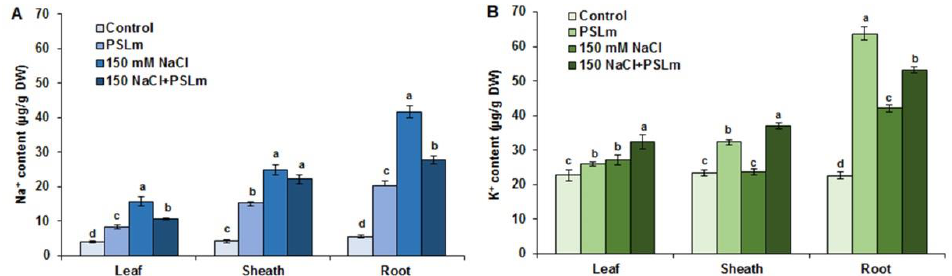
Figure 4. Na + content ( A ) and K + content ( B ) in leaves, sheaths, and roots under normal and salt- stressed (150 mM NaCl) durum wheat seedlings cultured in half-strength MS medium supplemented with (2 mg/mL) or without PSLm extract for 20 days. Values are means ± SEM (n = 3). Different letters indicate significant differences at p < 0.05.